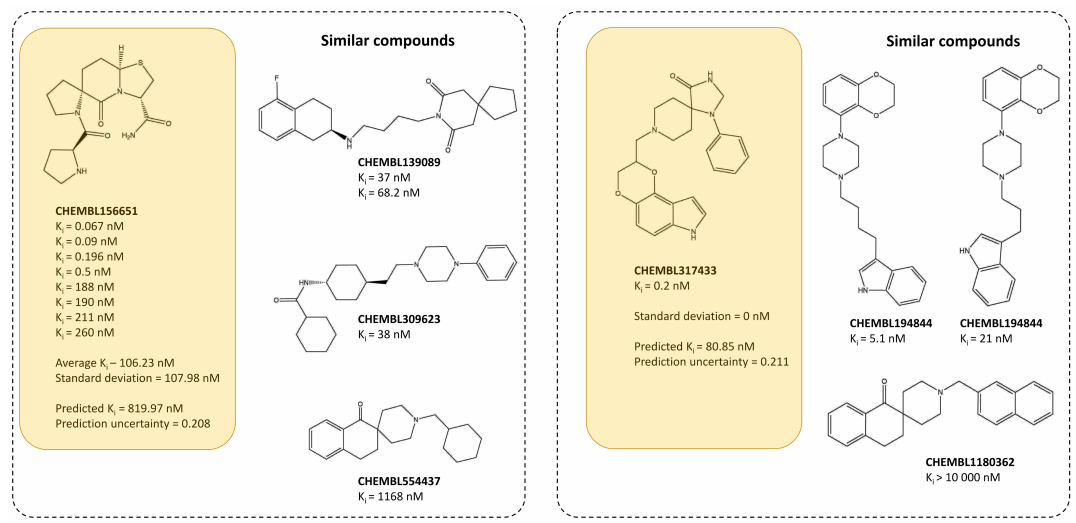
Figure 7. Analysis of selected dopamine D 2 ligands with terms of a ffi nity values provided in ChEMBL, predicted activity, prediction uncertainty and activity of structurally similar ligands (for Morgan